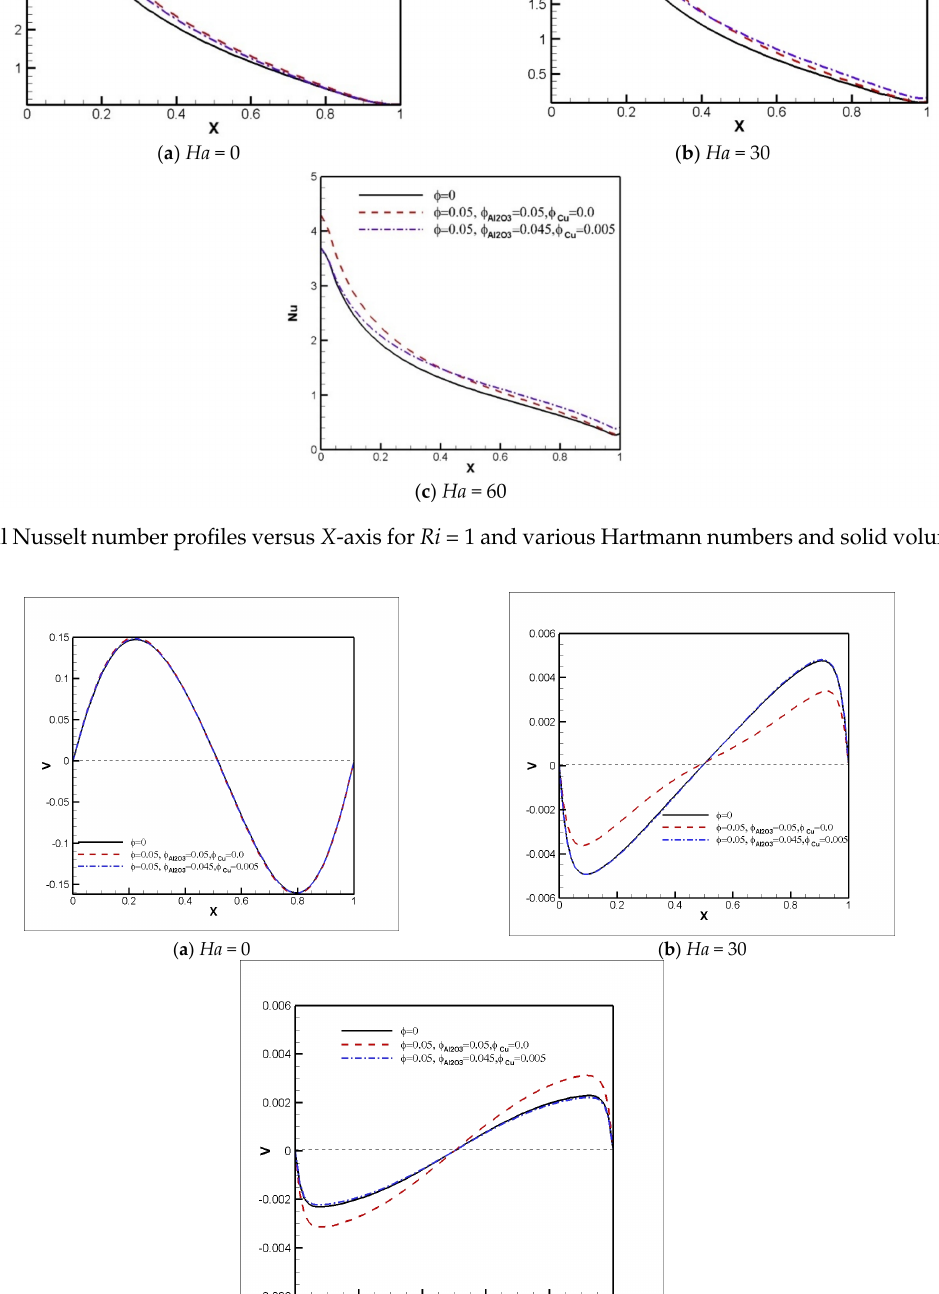
Figure 10. Vertical velocity profiles versus X -axis at Y = 0.5 for Ri = 1 and various Hartmann numbers and solid volume fractions.